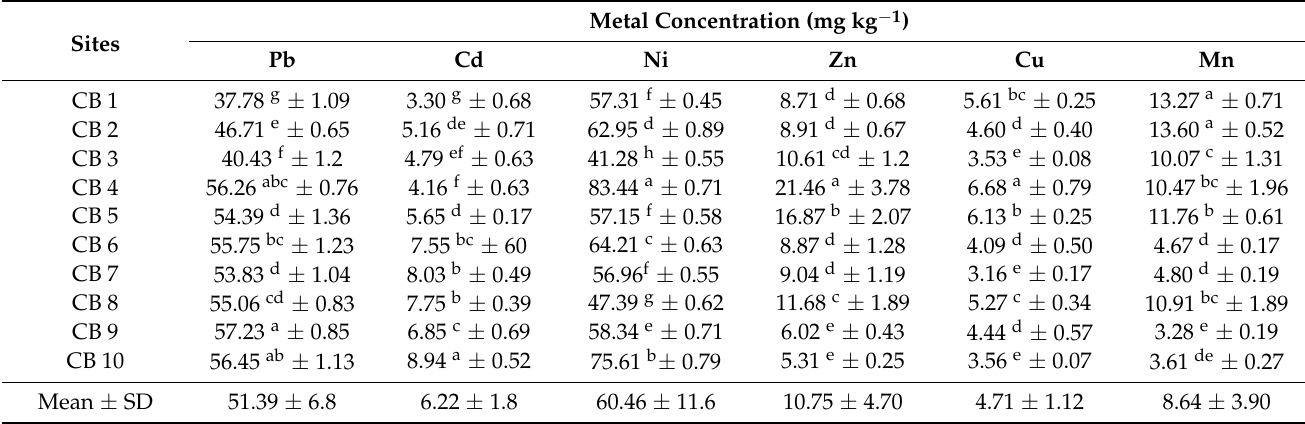
Table 1. Heavy metals concentration of 10 sampling sites of Chalan beel